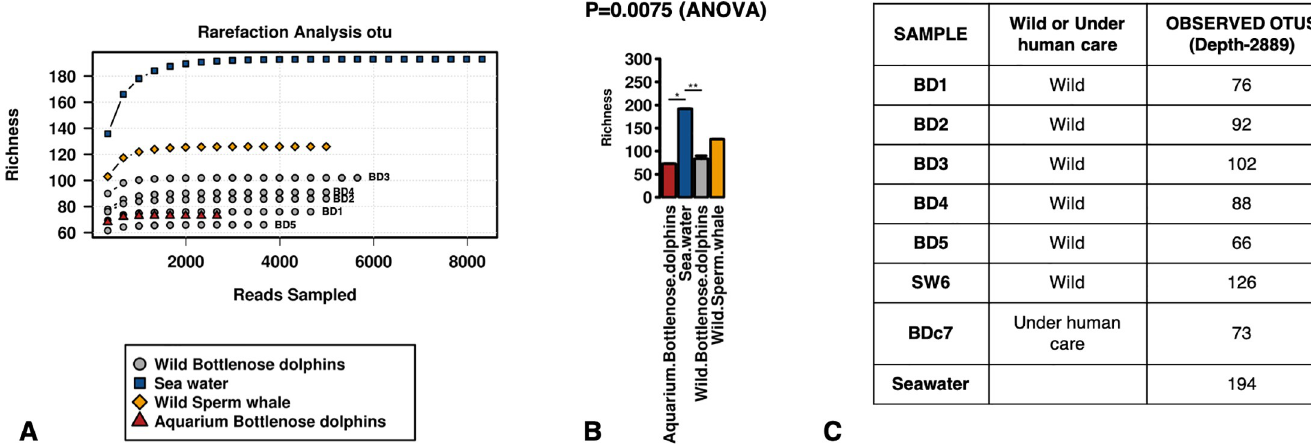
Fig 4. Alpha-diversity. Community richness evaluation by rarefaction analysis (A) and by ANOVA comparison of samples from different habitat (B), and the individual values of the observed OTUS (C).